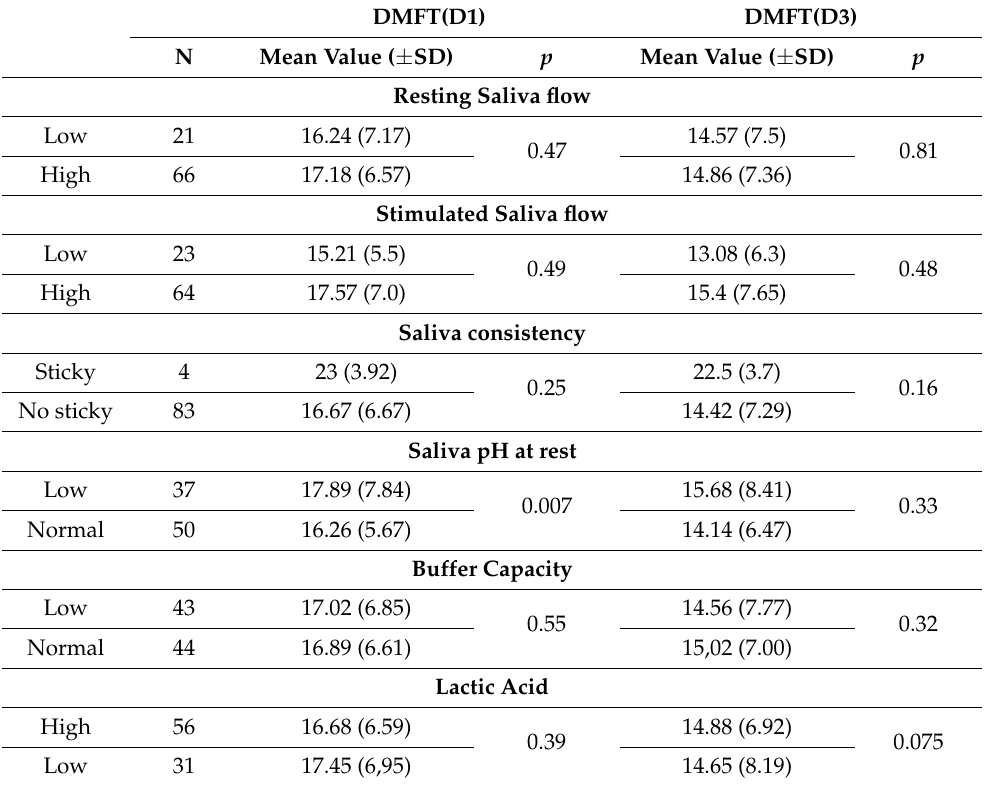
Table 1. Distribution of sample individuals per parameter according to DMFT (D1) and DMFT